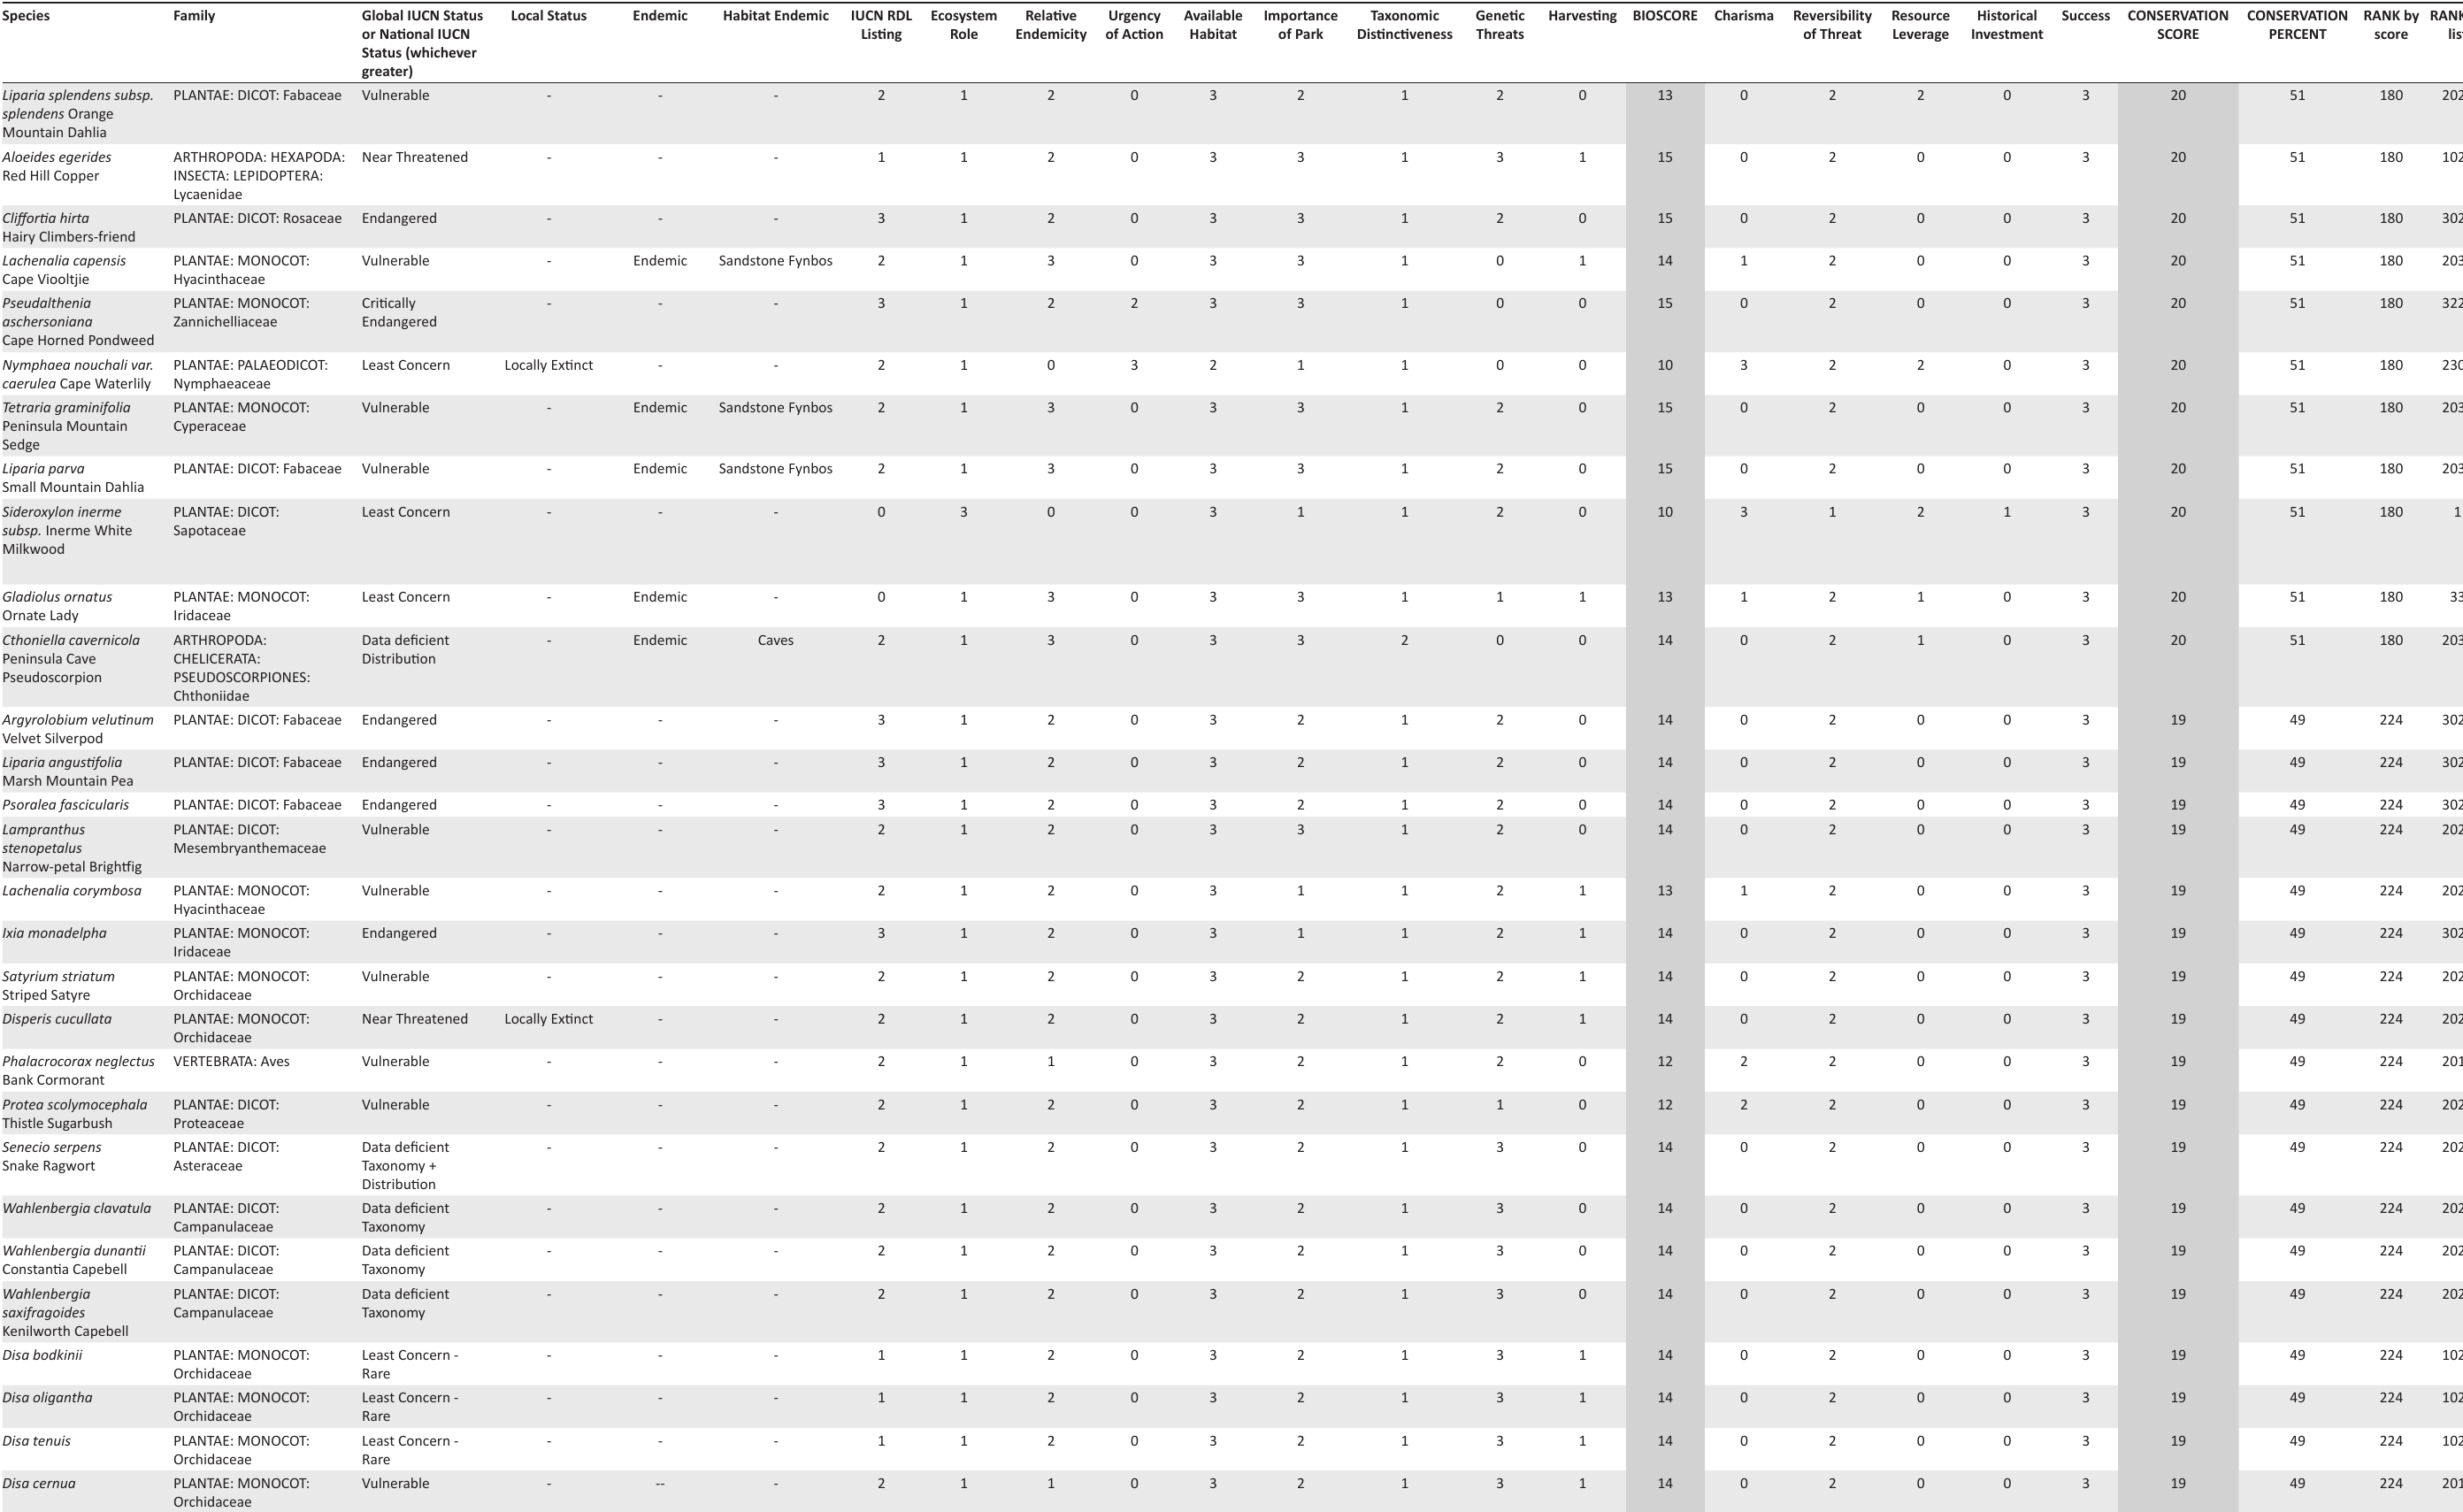
Online Appendix Table 1 (Continues...): List of species of Special Concern in the Table Mountain National Park and associated scores